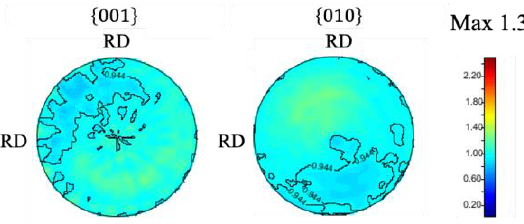
Figure 5. Pole figure maps of as-sintered sample obtained from neutron diffraction profiles.